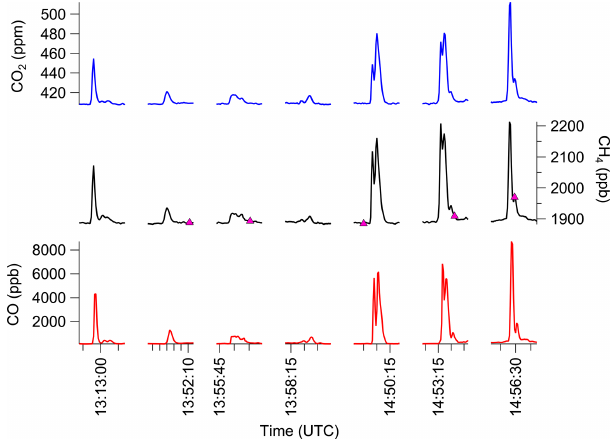
Figure 3. Time series of CO (red), CH 4 (black), CO 2 (blue), and concentrations in the plumes analysed for flight C005. Median WAS canister fill times are marked on the CH 4 time series as pink trian- gles. Note that some WASs taken in background regions are not shown